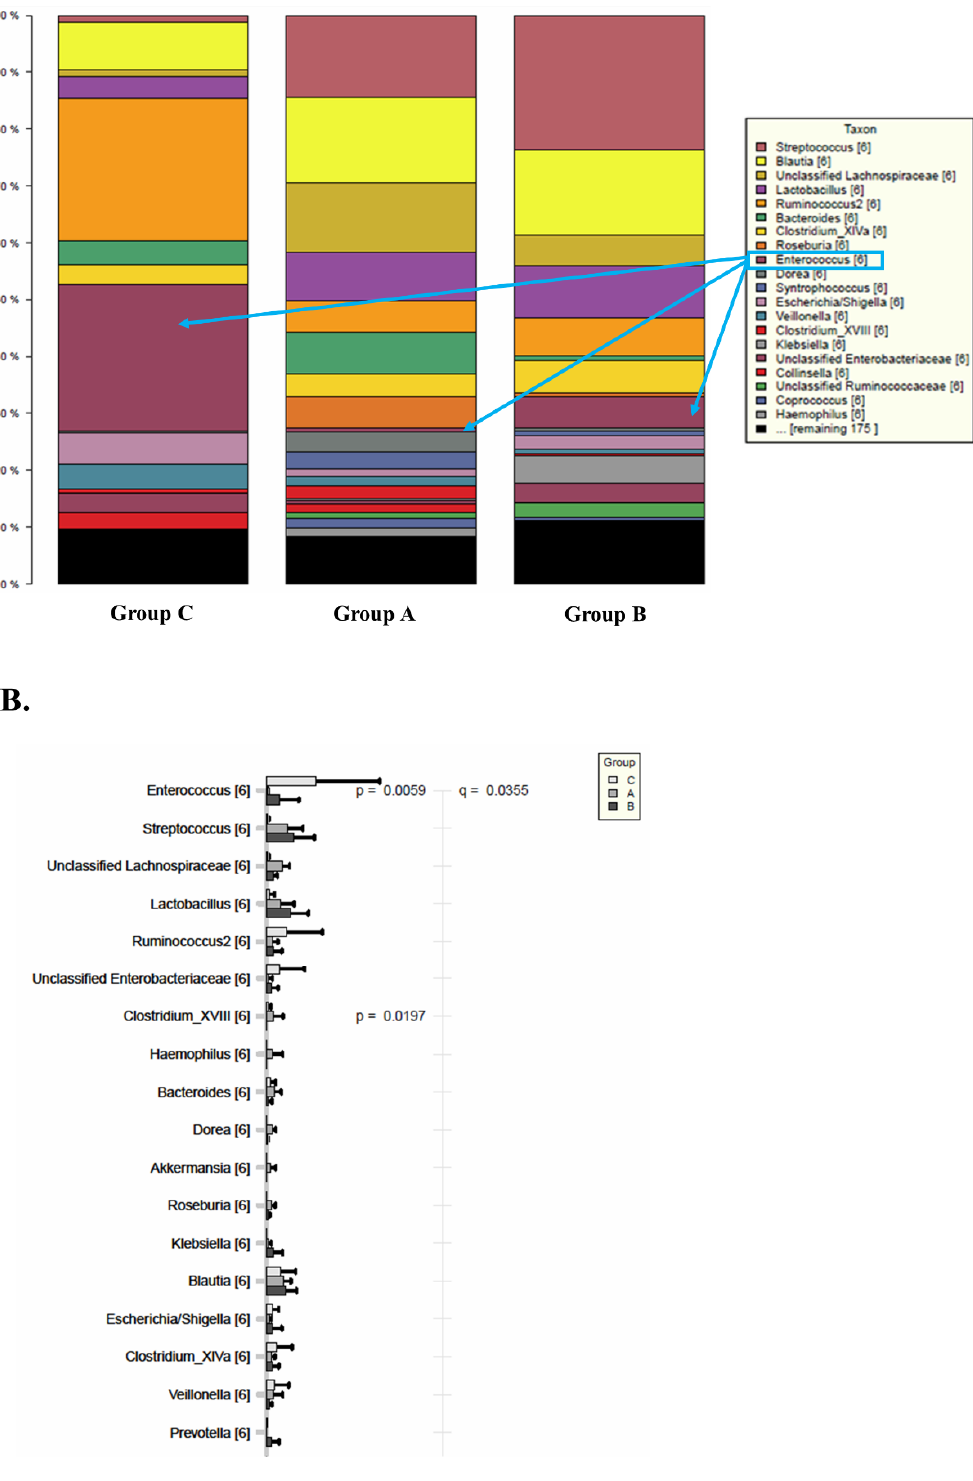
Figure 5. Relative bacterial composition and distribution of genus between Groups A, B and C of the transplanted intestine when compared to the transplanted intestine. ( A ) Histogram demonstrating taxonomic differences. ( B ) Histogram with relevant statistic for taxonomic differences between the groups. Overall, Enterococcus is a more highly expressed in Group C than Groups A and B or the control. Groups A, B and C demonstrate fewer Bacteroides, Prevotella and Faecalibacterium when compared to the control.